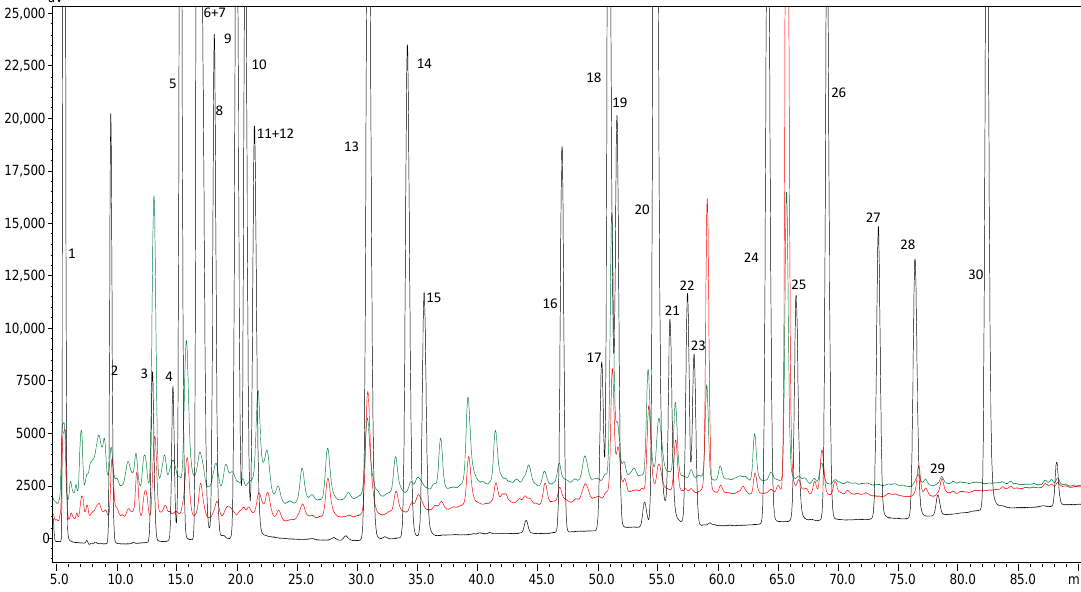
Figure 1. HPLC chromatograms at 280 nm for: polyphenols standard mixture of 10 mg / L (black line), and ultrasound-assisted extracts obtained at lab scale without an ice bath after 60 min of extraction for TN (Touriga Nacional, red line) and TR (Tinta Roriz, green line) vine-cane varieties; (1) gallic acid, (2) protocatechuic acid, (3) ( + )-catechin, (4) 4-hydroxyphenilacetic acid, (5) 4-hydroxybenzoic acid, (6) 4-hydroxybenzaldehyde, (7) chlorogenic acid, (8) vanillic acid, (9) ca ff eic acid, (10) syringic acid, (11) ( − )-epicatechin, (12) β -resorcylic acid, (13) p -coumaric acid, (14) ferulic acid, (15) sinapic acid, (16) naringin, (17) rutin, (18) resveratrol, (19) quercetin-3- O -glucopyranoside, (20) phloridzin, (21)